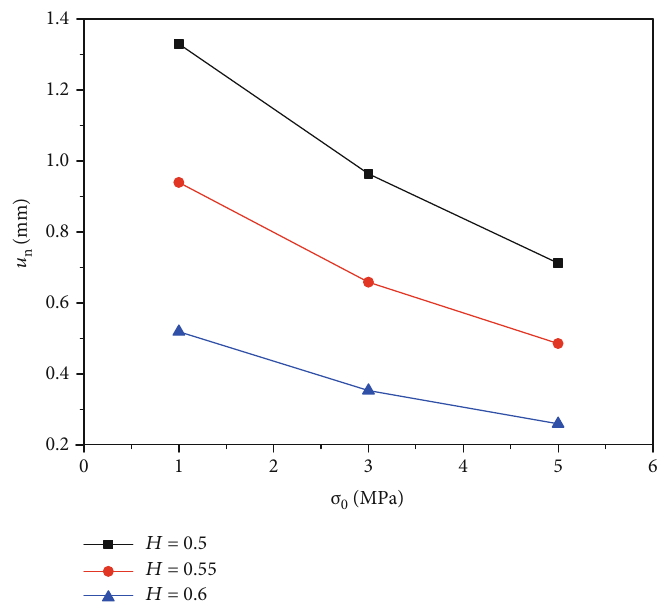
Figure 5: The normal displacement ( u